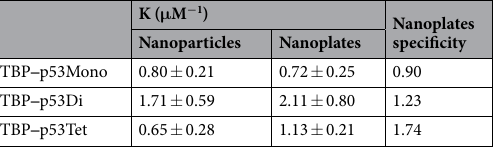
Table 2. Equilibrium constants of peptide adsorption for silver nanoplates and nanoparticles. Standard errors of mean are